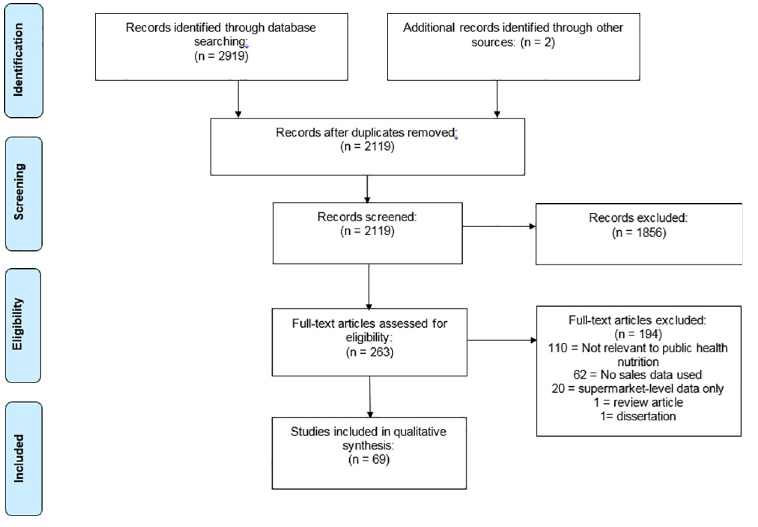
Fig 1. Study selection flow